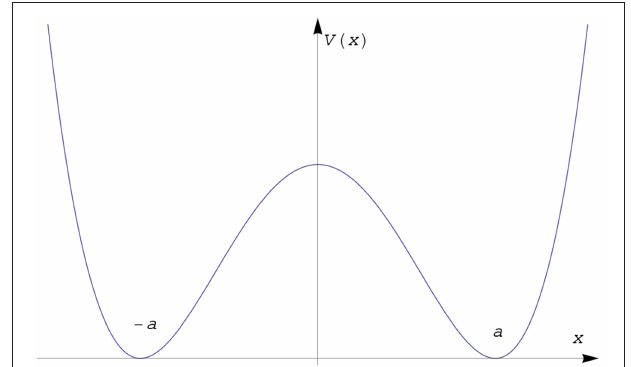
FIGURE 1 | Anharmonic